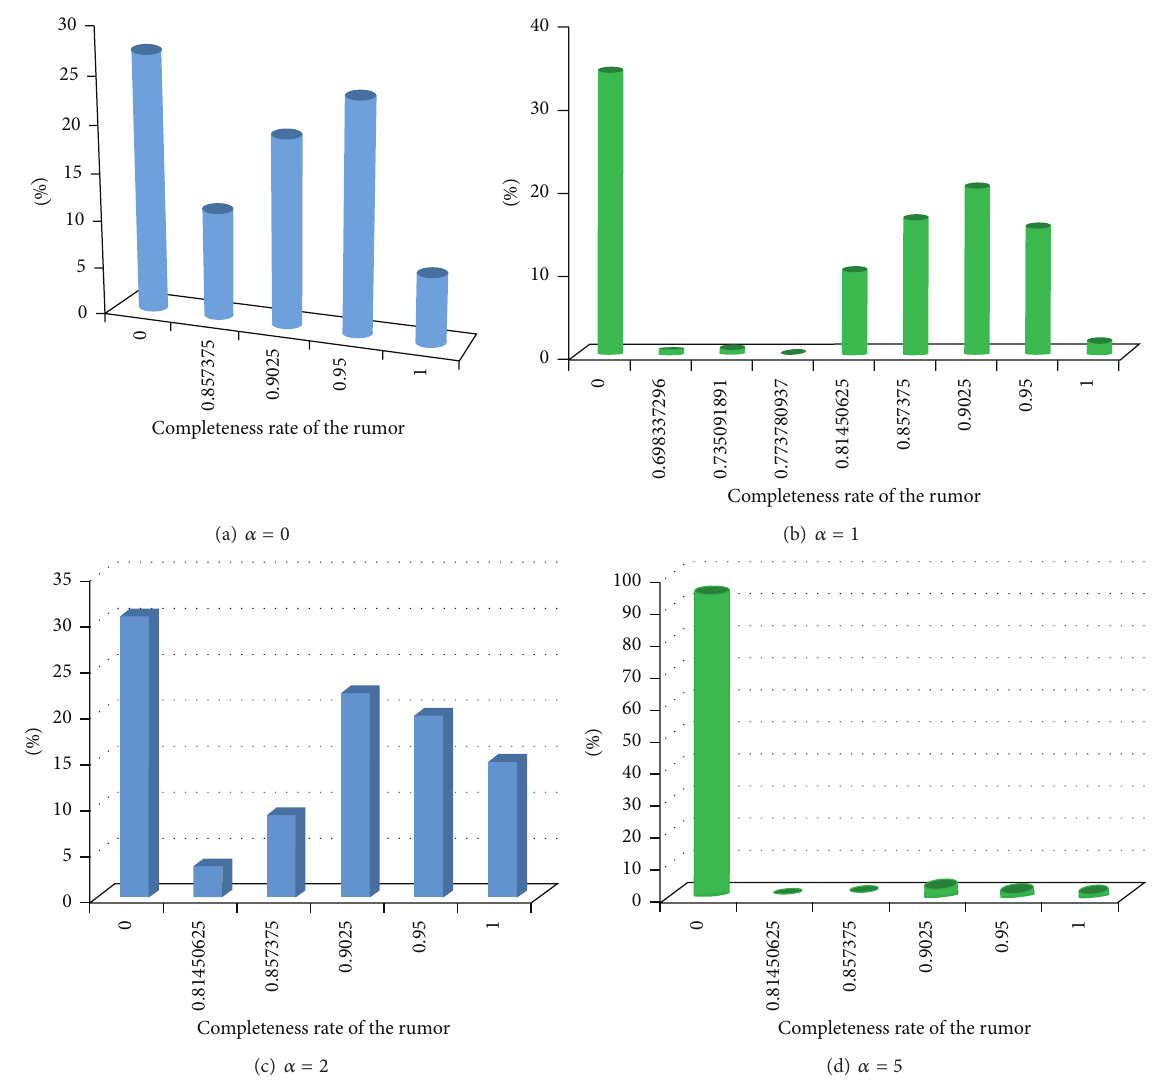
Figure 7: The completeness rate distribution with different values of 𝛼 , where 𝛽 = 10 , 𝑚 = 5 , 𝑝 1 = 1 , 𝜆 = 0.3 , 𝜅 = 0.00005 , 𝜏 = 0.95 , 𝛾 = 0.7 , = 100 , 𝜑 = 0.1 , and 𝑝 = 1 𝜔 = 0.9 , 𝜀 = 0.3 , 𝑝 0 1